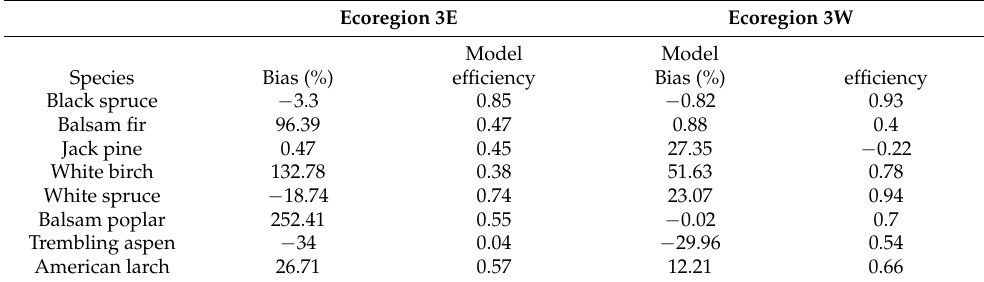
Table 7. Average bias and model efficiency coefficients between observations and predictions by Ecoregion included in the study in northern Ontario,